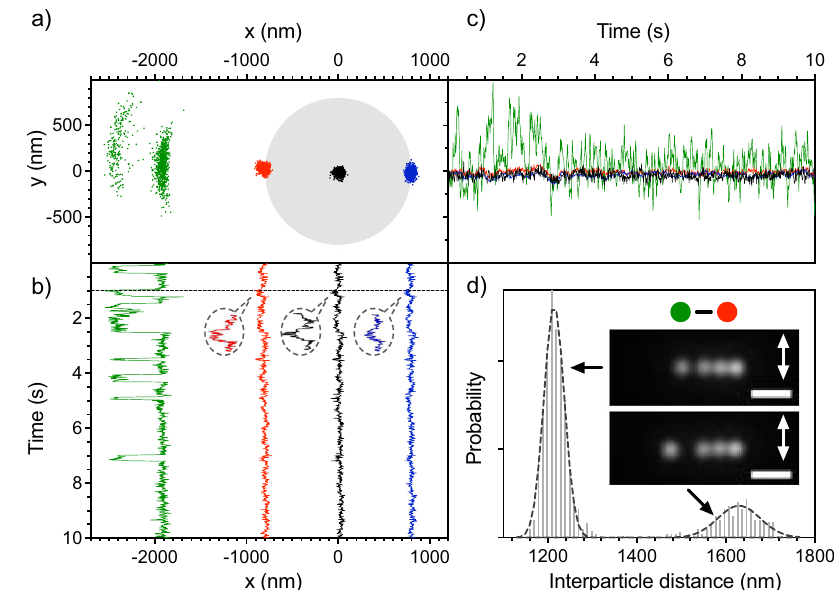
Fig. 3 | Spatial distributions for the four trapped Au NPs system. a The two- dimensional distribution in the x,y-focal plane, and the shadowed grey circle cor- respondsto theestimated diameterof laserfocus(1.8 μ m). b , c Trajectoriesof NPs in x- and y-directions over time, and their colors (black, red, blue and green) cor- respond to each NP in the two-dimensional distribution. The dashed-line bubbles show a magni fi cation ofthe 3LA NP ’ s motion to showhowthey are affected by the